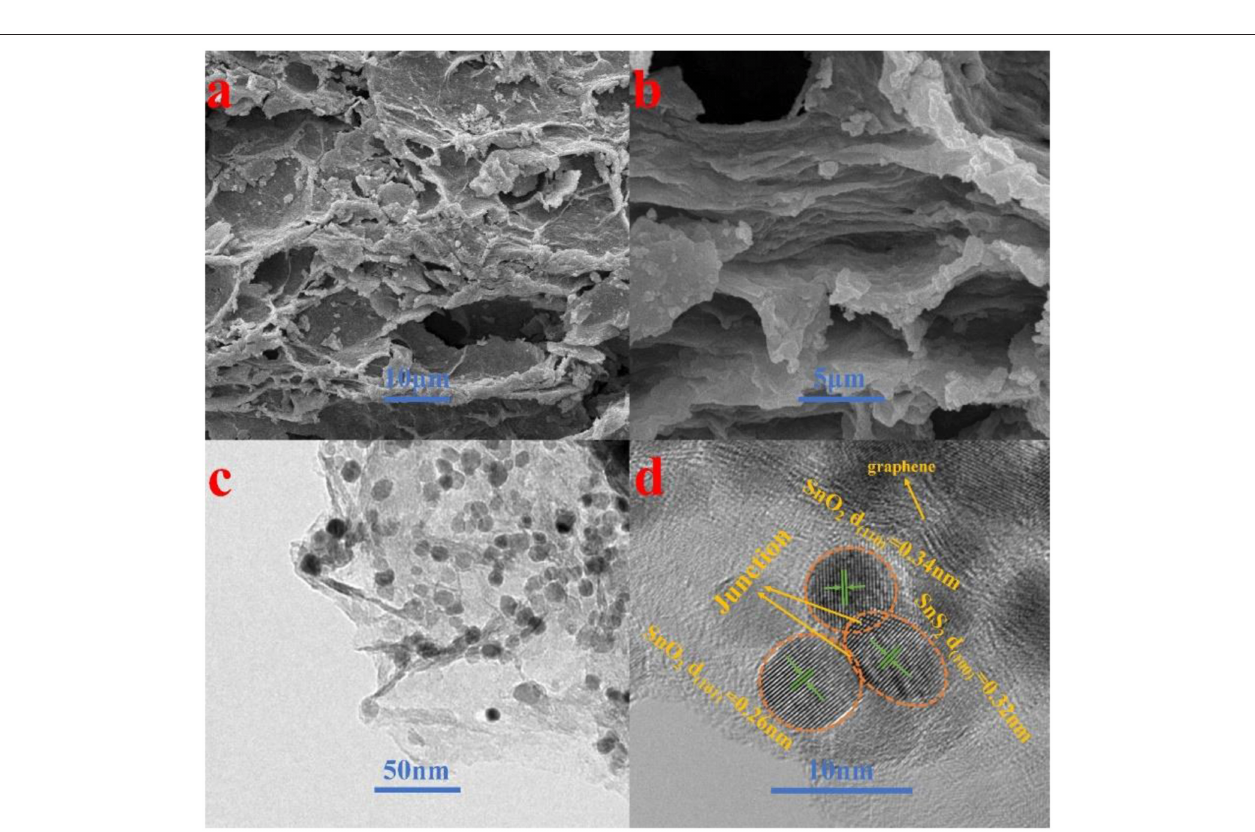
FIGURE 3 | (a,b) SEM, (c) TEM, and (d) HRTEM images of SnO 2 -SnS 2 @C/NG composite.